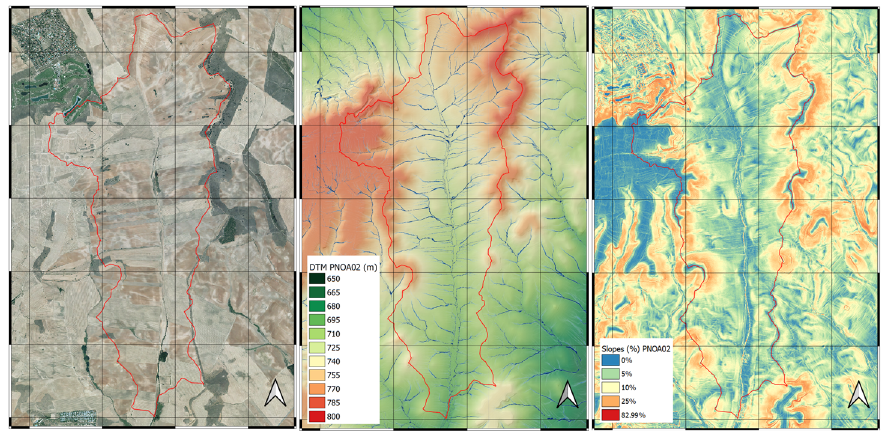
Figure 1. Monitored basin in Daganzo de Arriba. Left, aerial image from PNOA (National Plan for Aerial Orthophotography); centre, DTM; and right, slope map. Zebra frame segments of 1 km. It is an elongated basin with topographic heights ranging between 689.23 and 789.70 m above sea level. The basin has slopes of less than 10%, except near the border of